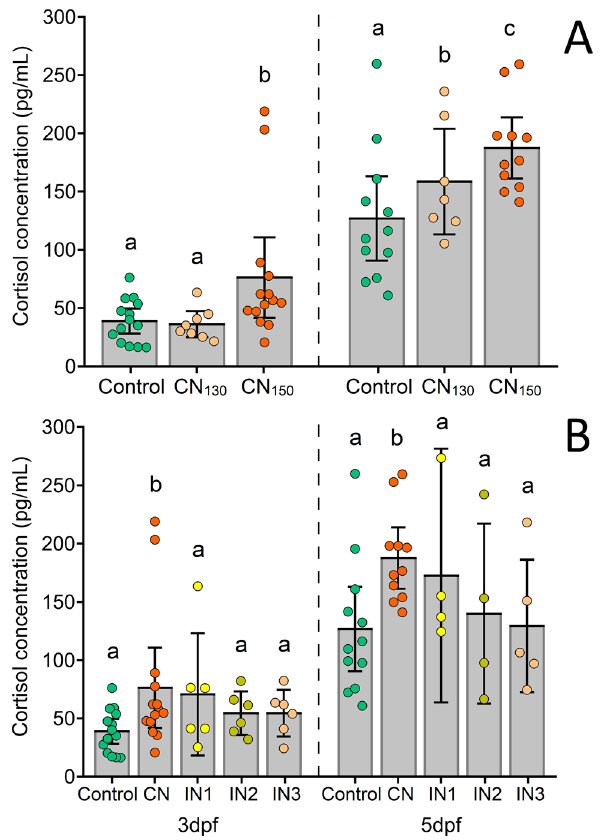
Figure 3. Whole-body cortisol levels from larval zebrafish exposed to ( A ) continuous noise at different amplitudes (3 dpf: F (2, 35) = 4.84, p = 0.014; 5 dpf: F (2, 29) = 4.37, p = 0.023) and ( B ) varying noise temporal patterns at 150 dB re 1 μPa (3 dpf: F (4, 45) = 2.23, p = 0.082; 5 dpf: F (4, 35) = 2.65, p = 0.052). Control- silent conditions, CN- continous noise at either 130 (CN 130 ) or 150 dBre 1 μPa (CN 150 ), IN- intermittent regime with short (IN1), medium (IN2) and long noise segments (IN3). Error bars represent 95% confidence intervals. Different letters indicate statistically significant differences between specific groups based on post hoc